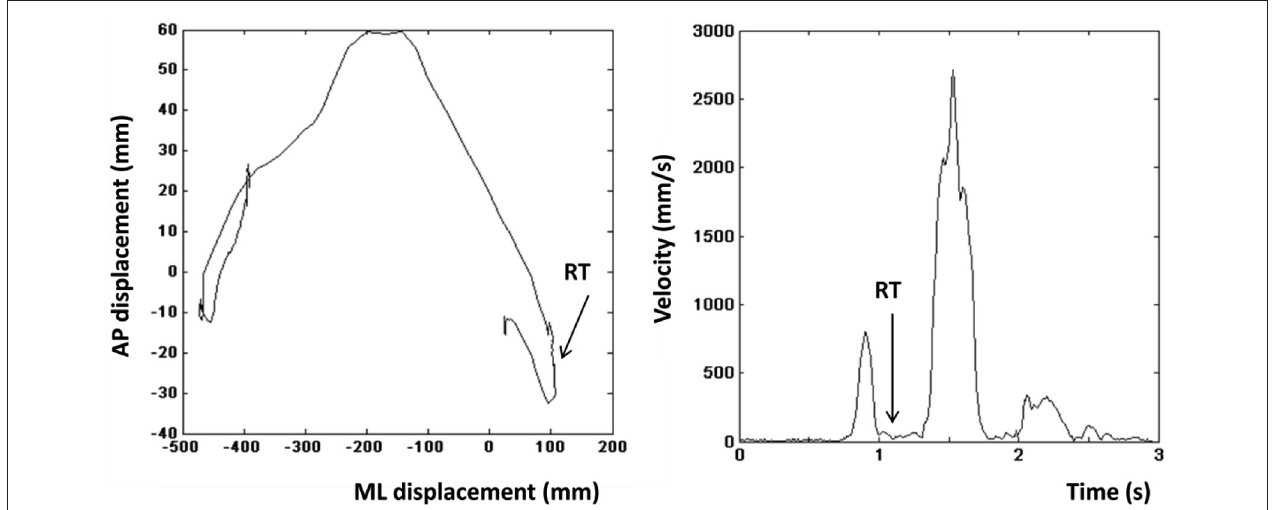
FIGURE 2 | Left: Center of pressure (COP) displacement of a representative leftward step. Right: Velocity profile of the step shown in the left panel. Arrow indicates the moment that was defined as the reaction